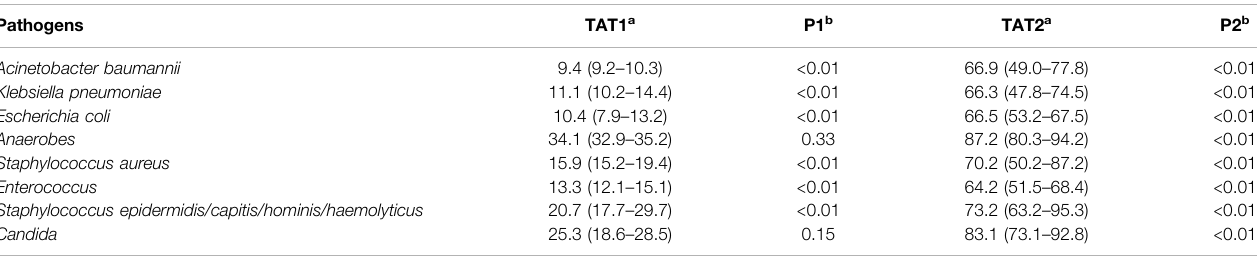
TABLE 1 | Comparison of plasma mcfDNA sequencing and blood culture testing in terms of timeliness.